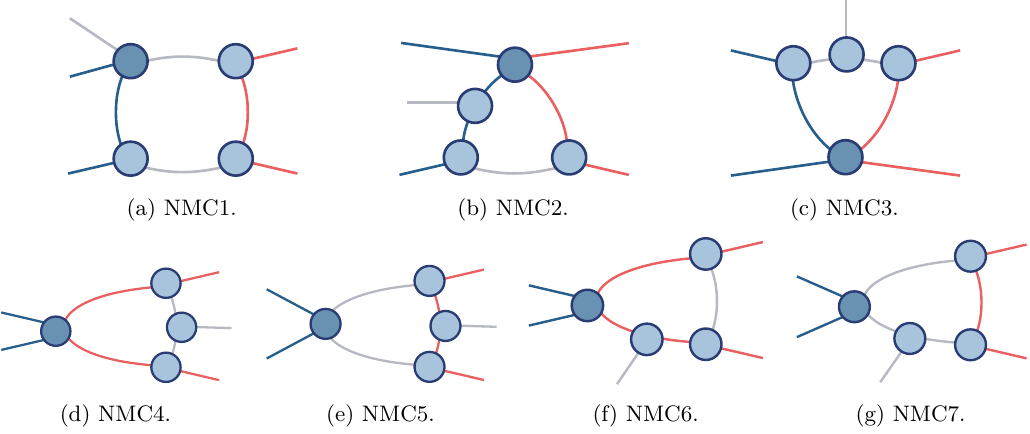
Figure 7 . Next-to-maximal box cuts of the one-loop five-point amplitude. Light blue blobs repre- sent three-point amplitudes, darker blobs represent four-point amplitudes, and exposed legs repre- sent on-shell